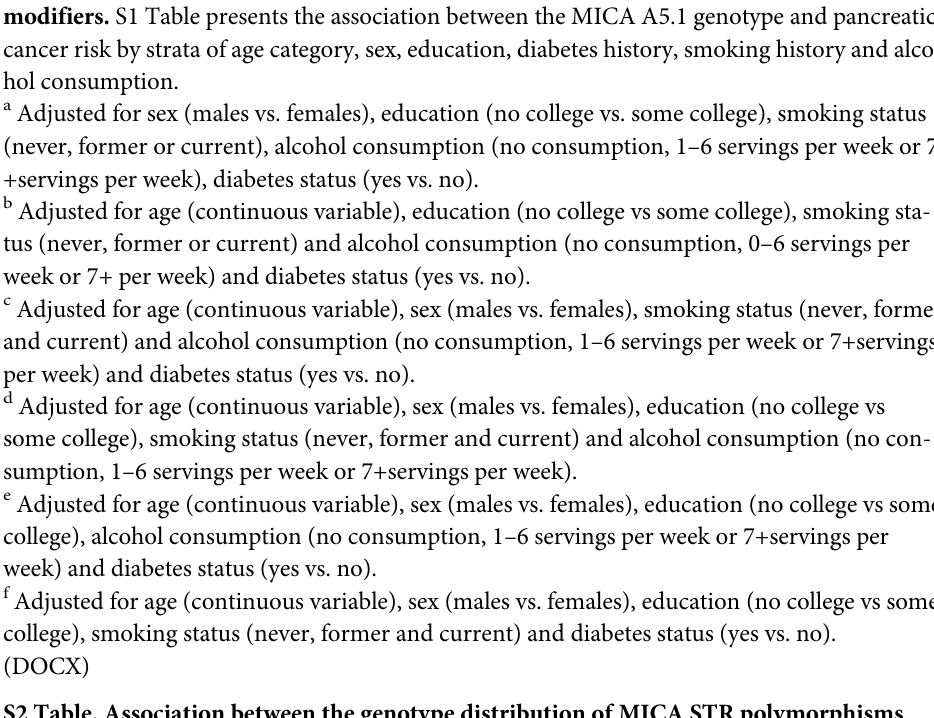
S2 Table. Association between the genotype distribution of MICA STR polymorphisms (dominant model) and pancreatic cancer risk. S2 Table presents the association between the distribution of other short tandem repeat MICA genotypes (A4, A5, A6 and A9) and pancre- atic cancer risk. a